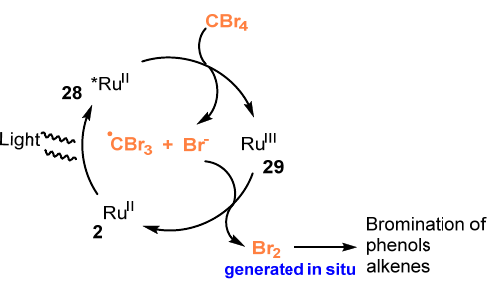
Scheme 58. General mechanism for in situ generation of bromine.